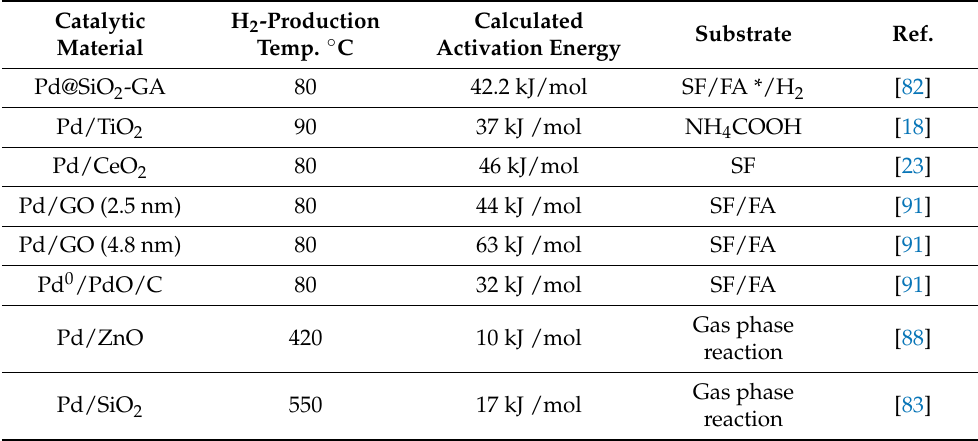
Table 1. Pd-based materials used for H 2 -production via dehydrogenation of